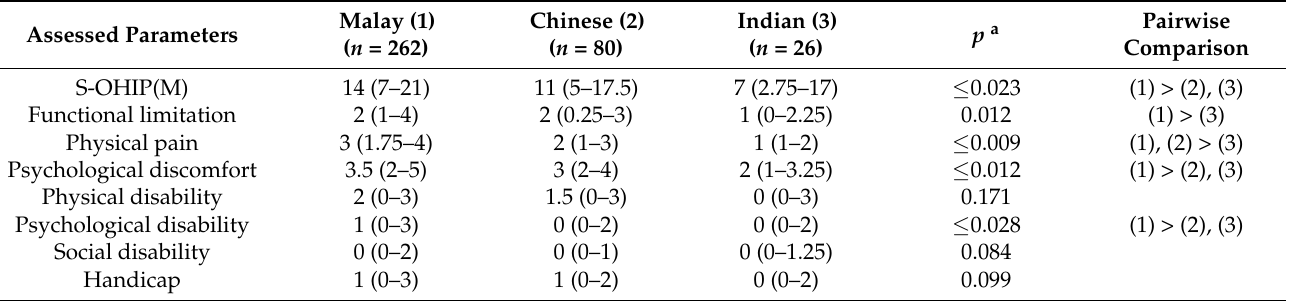
Table 4. Comparison of S-OHIP(M) total and domain scores [median (inter-quartile range)] between ethnic groups ( n =